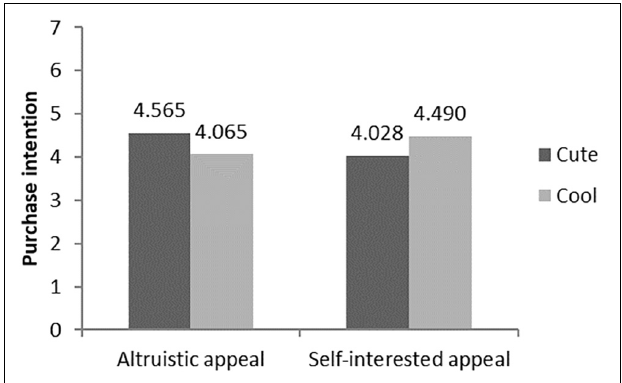
FIGURE 5 | The interaction of brand anthropomorphic images and advertising